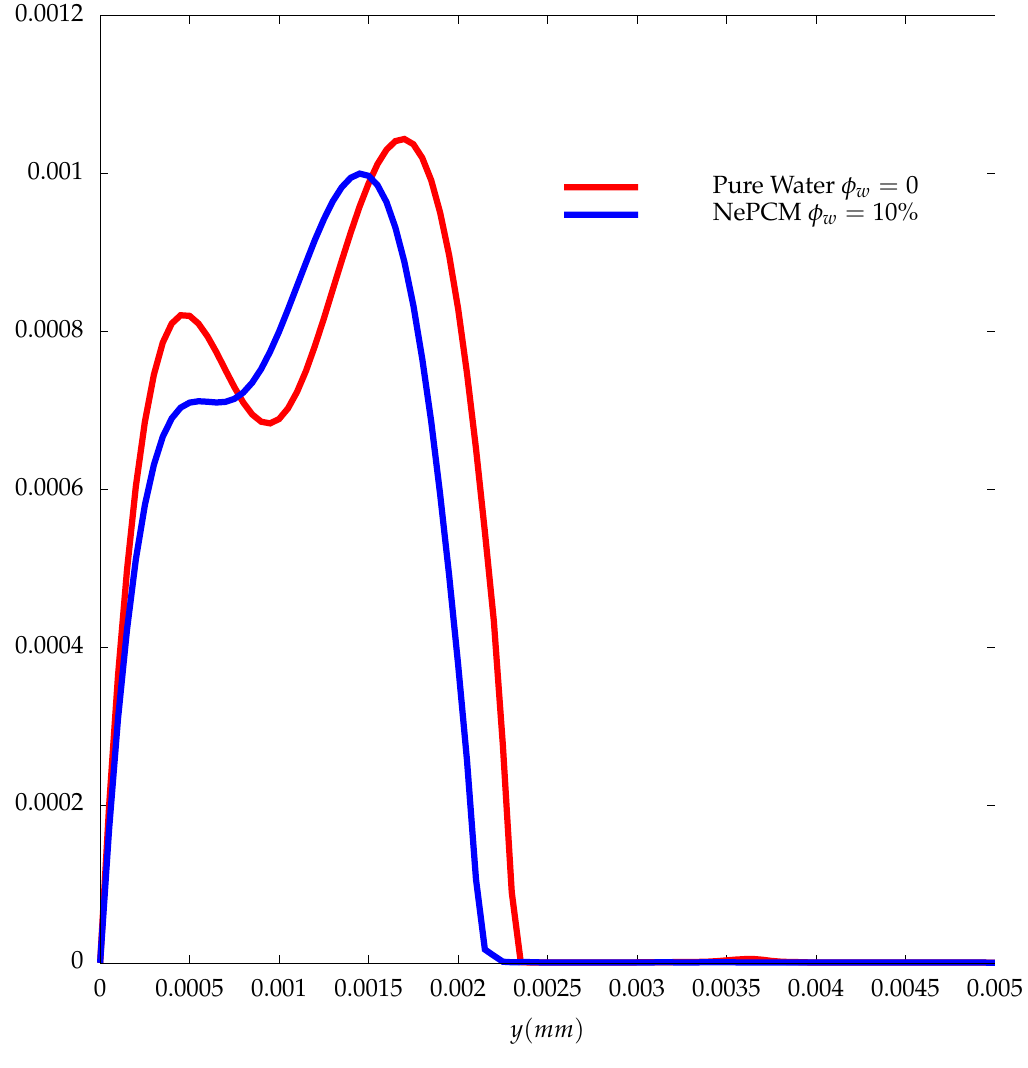
Figure 10. Compression between the Velocity evolution along vertical line located at x = 0.005 mm, and a long the y -axis for the case of φ w = 0, and